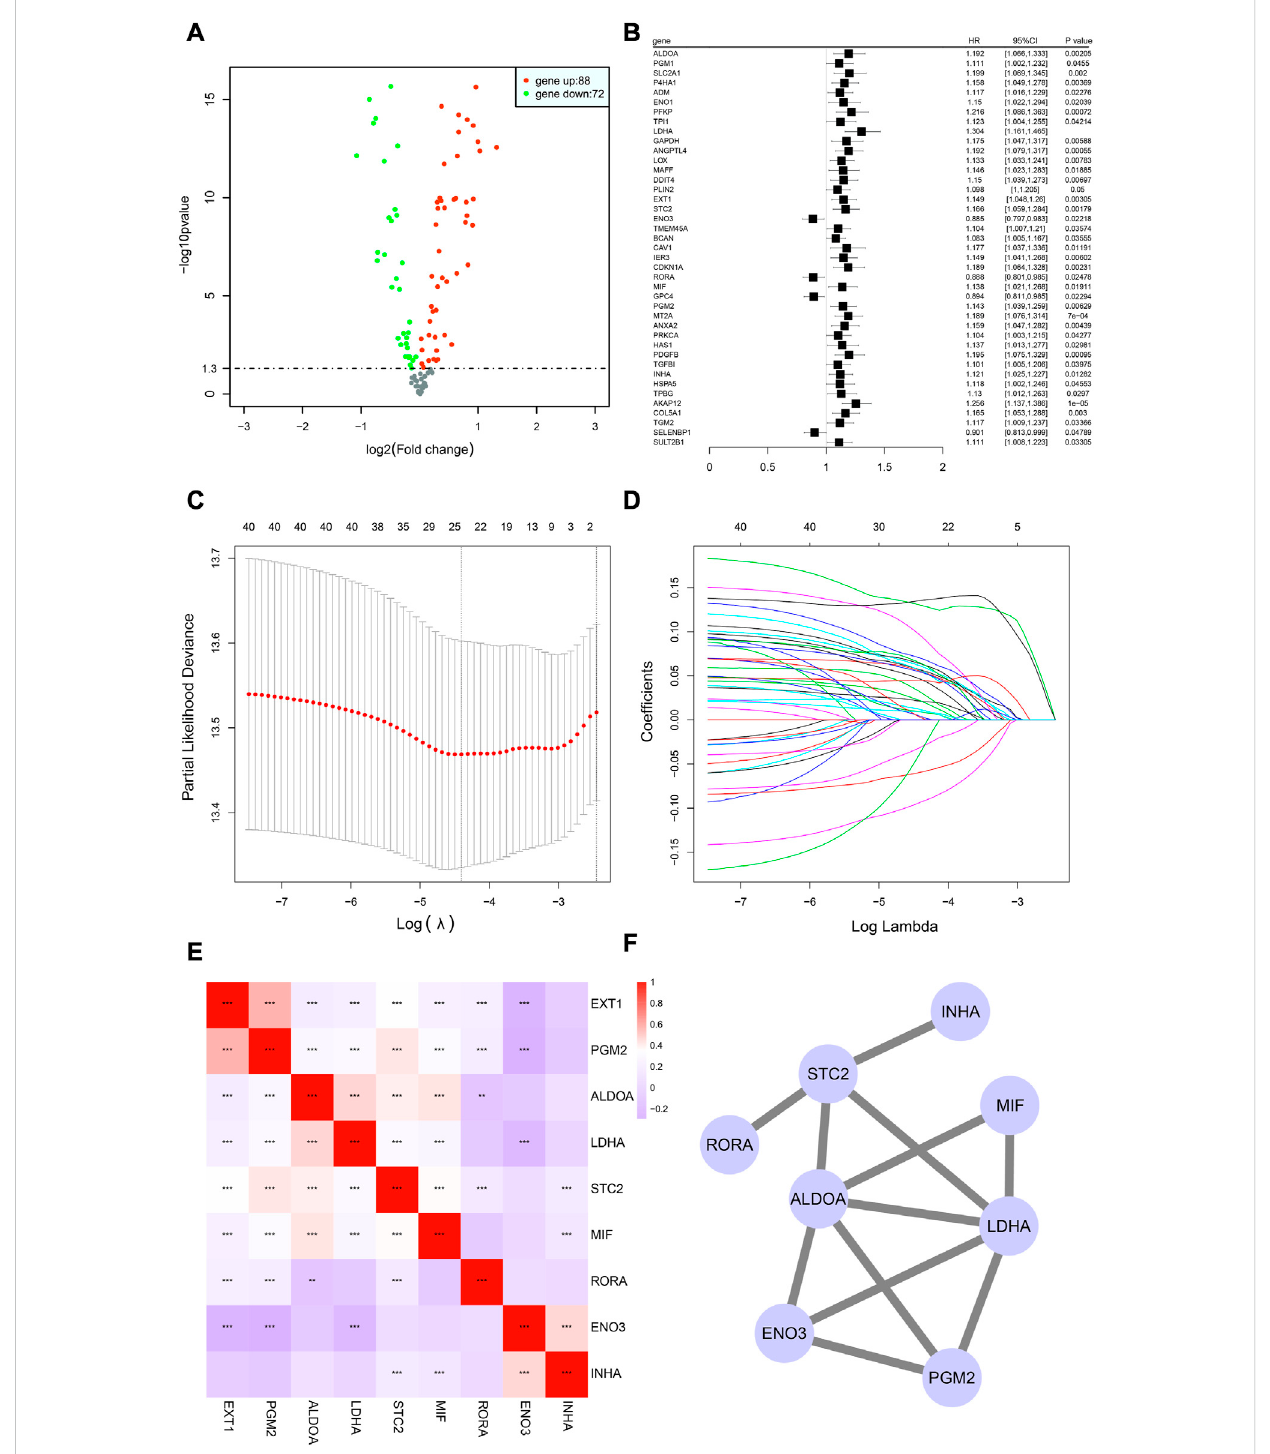
FIGURE 2 Building of the HRG model in the TCGA-NSCLC cohort. (A) Volcano graphic showing how HRG expression differs in tumor and normal samples based on both fold change and statistical signi fi cance. (B) Results of univariate Cox regression analysis presented in a forest plot, with gene name in the fi rst column and box plot depicting the hazard ratio (HR) and its corresponding 95% con fi dence interval in the second column. (C,D) LASSO analysis for estimating the number of contributing components. (E) Correlation analysis of HRG expression in the risk model using Spearman ’ s correlation. * p < 0.05; ** p < 0.01; *** p < 0.001. (F) Results of protein interaction analysis of the HRG